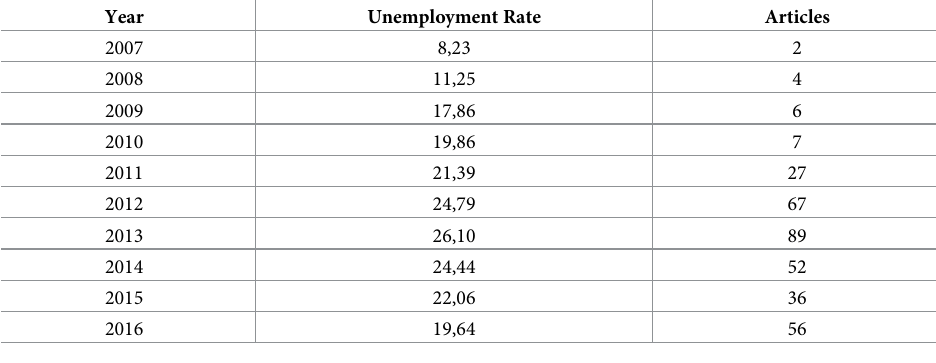
Table 6. Correlation between the unemployment rate and number of articles.